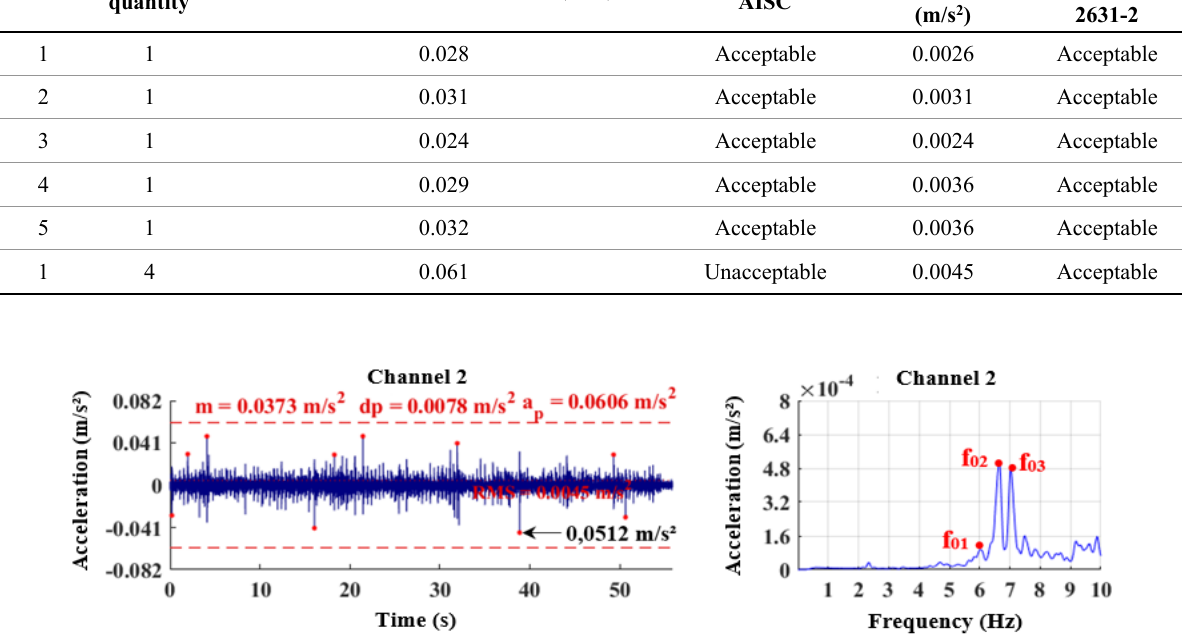
Figure 16. Dynamic response from floor 1 for four fast walking people on a random